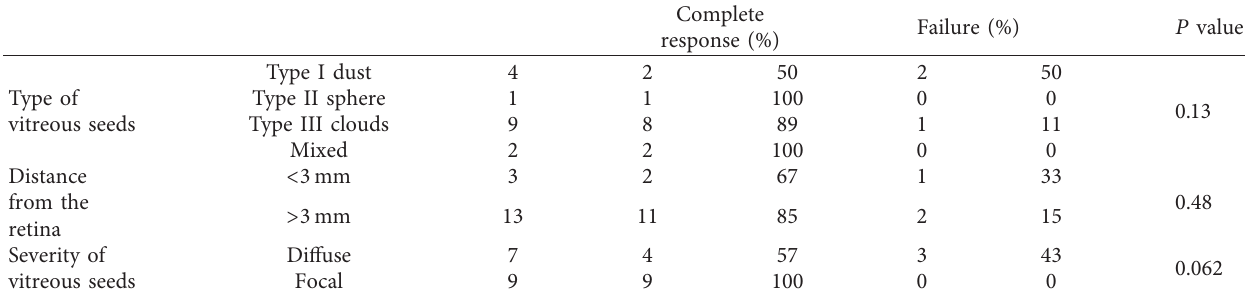
Table 2: Tumor characteristics and management